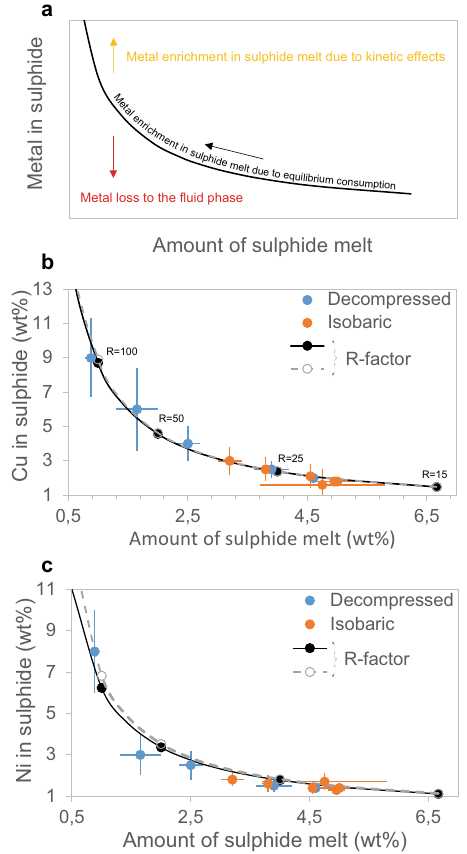
Fig. 5 Metal content of the sulphide melt. a Theoretical scheme showing how sulphide consumption at equilibrium conditions increases the metal content of the sulphide melt, following the black line, which is calculated after ref. 9 : Csulph = C° D ( R + 1)/( R + D ), where Csulph is the metal concentration in the sulphide melt, C° is the metal content of the silicate melt before sulphide segregation, D is the metal partition coef fi cient between sulphide and silicate melts, and R is the silicate/sulphide mass ratio. Departure from equilibrium conditions could be due to either metal transfer to the fl uid phase (red arrow), or metal enrichment in the sulphide melt due to delayed diffusion of metals (green arrow). Average Cu ( b ) and Ni ( c ) contents of the sulphide melt versus its amount in each sample determined by mass balance calculations. Error bars represent the standard deviation around the mean values. The solid and the dashed lines indicate equilibrium contents for variable silicate/sulphide mass ratios (indicated on the line), as in ( a ), calculated for the minimum (solid line) and the maximum (dashed line) Dsulf/sil values determined in this study.